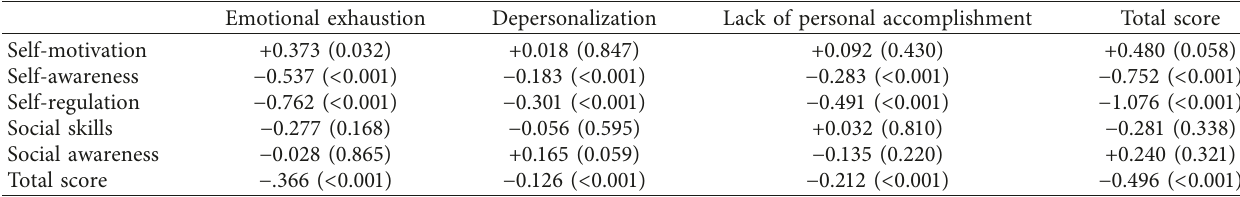
Table 6: Comparison of burnout dimensions according to emotional intelligence aspects using β linear regression ( P value).